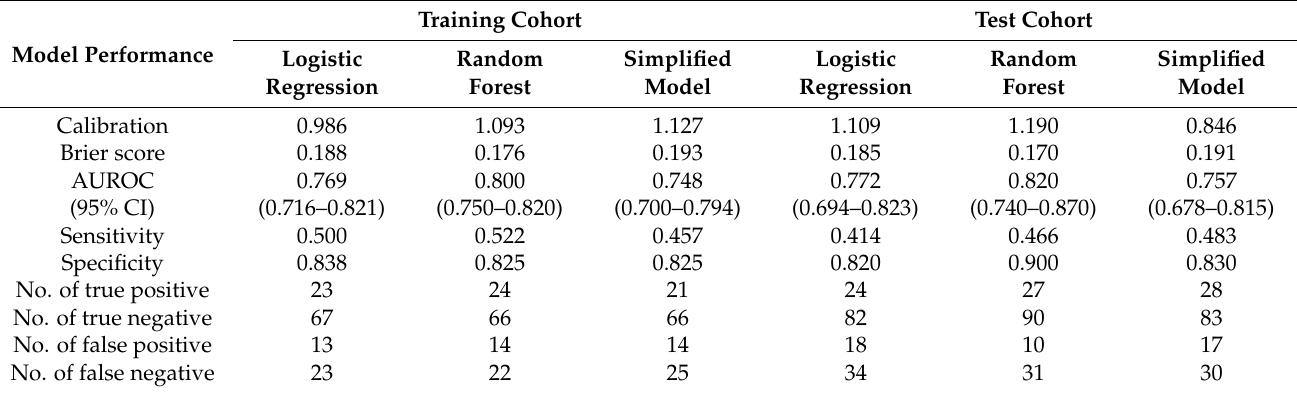
Table 3. Model performance in training and test cohorts.